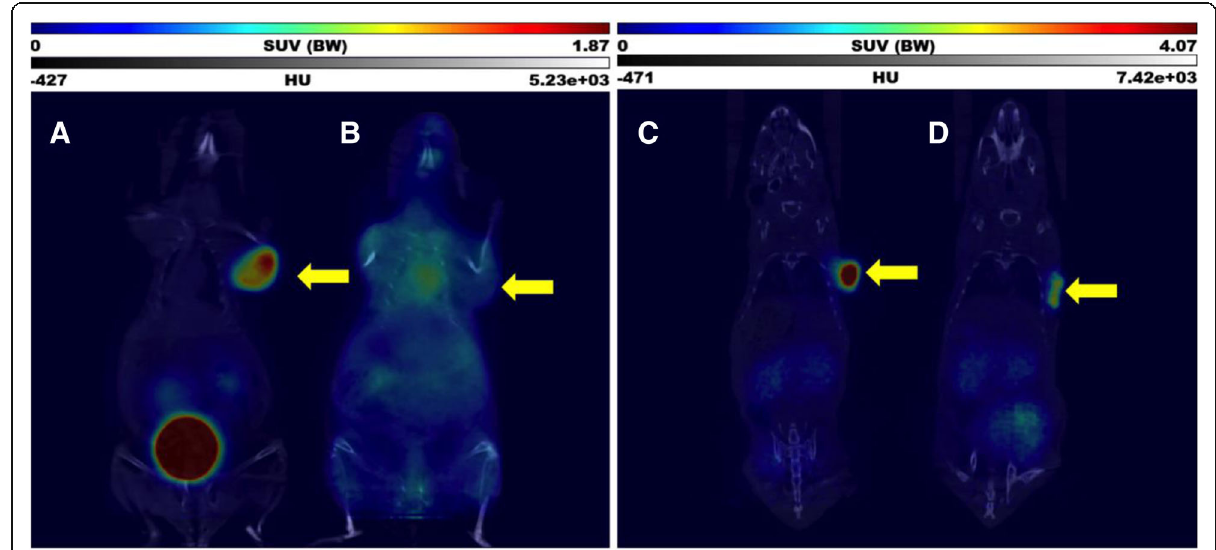
Fig. 3 Coronal sections of PET images summarised from 1 to 2 h p.i. (midframe time 90 min), from dynamic PET studies of [ 68 Ga]Ga-DATA-TOC (A, B) and [ 68 Ga]Ga-DOTA-TOC (C, D) distribution in MPC-mCherry tumour-bearing NMRI nu/nu mice after single intravenous injections of the